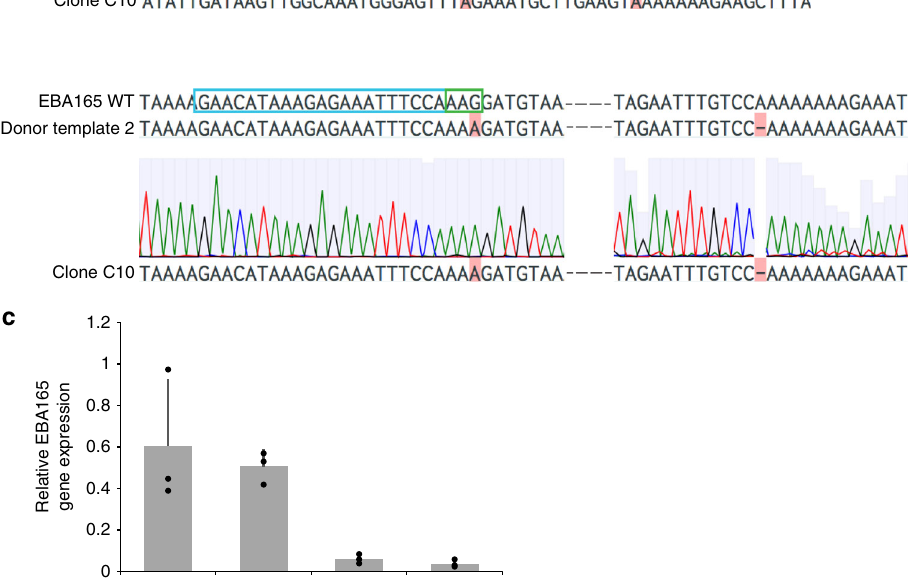
Fig. 4 PfEBA165 frameshift correction results in down-regulated transcription. a Schematic showing genome editing strategy. P. falciparum 3D7 parasites were transfected with plasmids containing Cas9 expression cassettes and sgRNAs targeting near the two PfEBA165 frameshifts present in the endogenous gene, along with linear PCR donor templates containing corrected versions of these frameshifts. Cas9 mediated homologous recombination would result in correction of either one or both frameshifts, depending on whether one or both sgRNA containing plasmids were transfected. The plasmids contained the human dihydrofolate reductase ( hDHFR ) gene for selection, Cas9 and sgRNA expression were driven by endogenous calmodulin (cam) and U6 promoters, respectively, b Sanger sequencing of cloned double transfectant parasite line (C10) con fi rms correction of both frameshifts, with correction for 5 ′ frameshift shown in top row and 3 ′ frameshift shown below. Blue boxes outline sgRNA target sequences and green boxes outline PAM sites within the target sequence. The donor template incorporated changes that eliminate the PAM site, preventing re-cleavage of corrected genes, but do not affect the translated amino acid sequence. c Quantitative RT-PCR of PfEBA165 expression in 3D7 (parental line). YB4 (cloned transfectant with the 3 ′ frameshift corrected) and C10 and D3 (cloned transfectant lines with both the 5 ′ and 3 ′ frameshifts corrected). To control for differences in relative abundance of mature schizonts in the parasite culture before RNA extraction, PfEBA165 transcript levels were normalized to Pfcyp87 (stable expression throughout cell cycle) and expressed relative to PfAMA1 (late-stage speci fi c expression). Data points represent mean values of three biological replicates. Error bars represent standard deviation and statistical signi fi cance was determined using a one-way ANOVA with Dunnet ’ s multiple comparison test for each erythrocyte category. ** p < 0.01. Source Data are provided as a Source Data